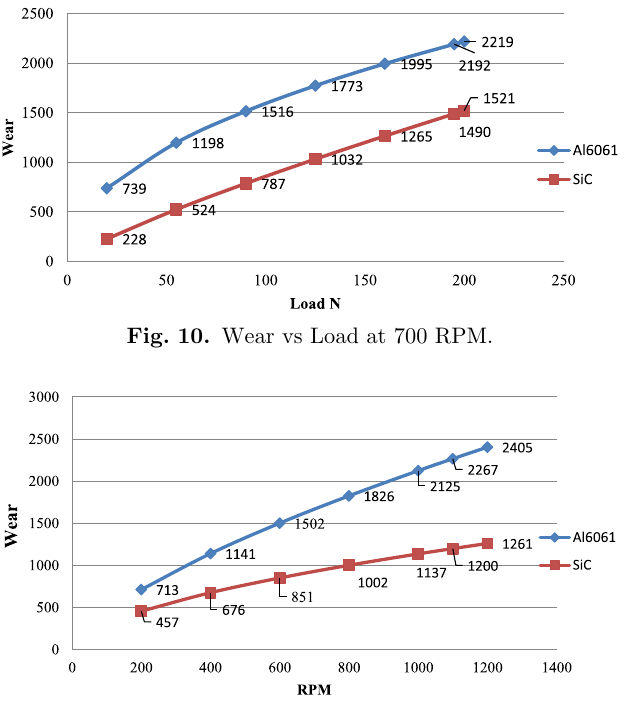
Fig. 11. Wear vs RPM at 110N load.